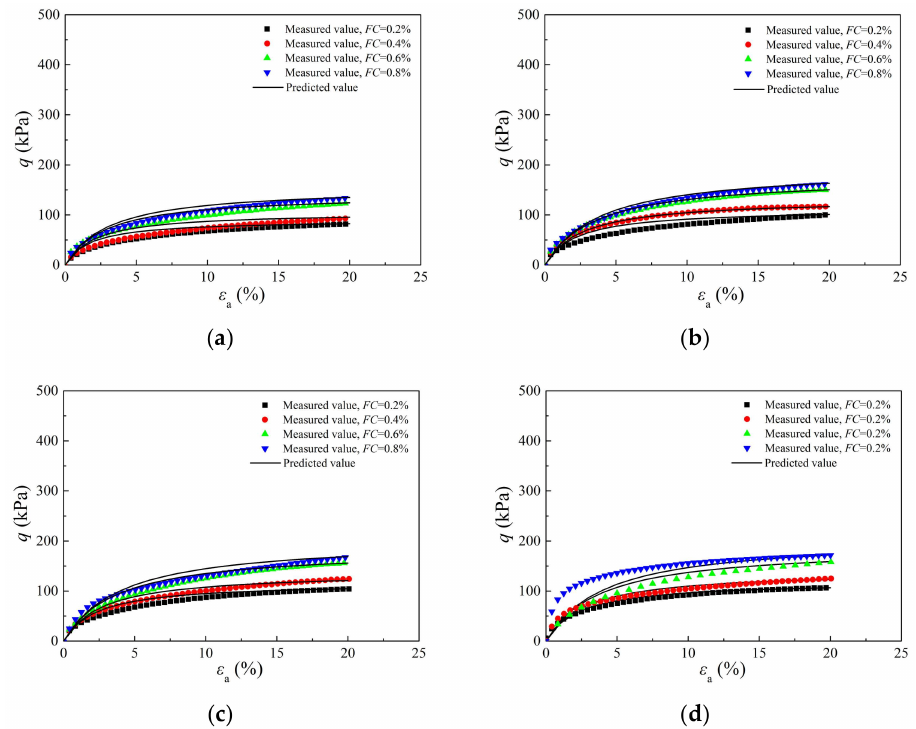
Figure 8. Results comparison between measured and predicted results under 25 kPa cell pressure: